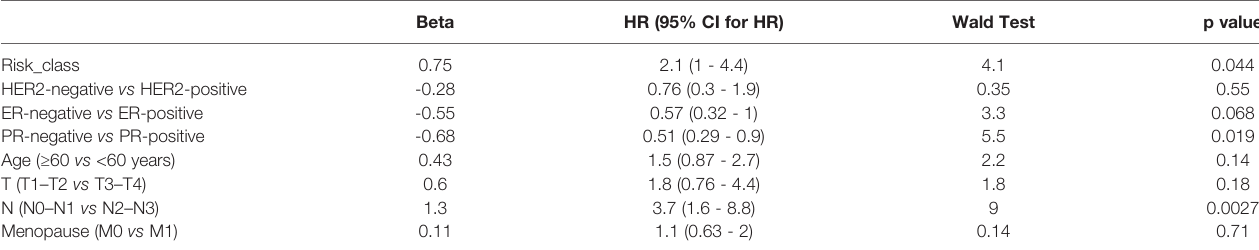
TABLE 4 | Univariate COX regression